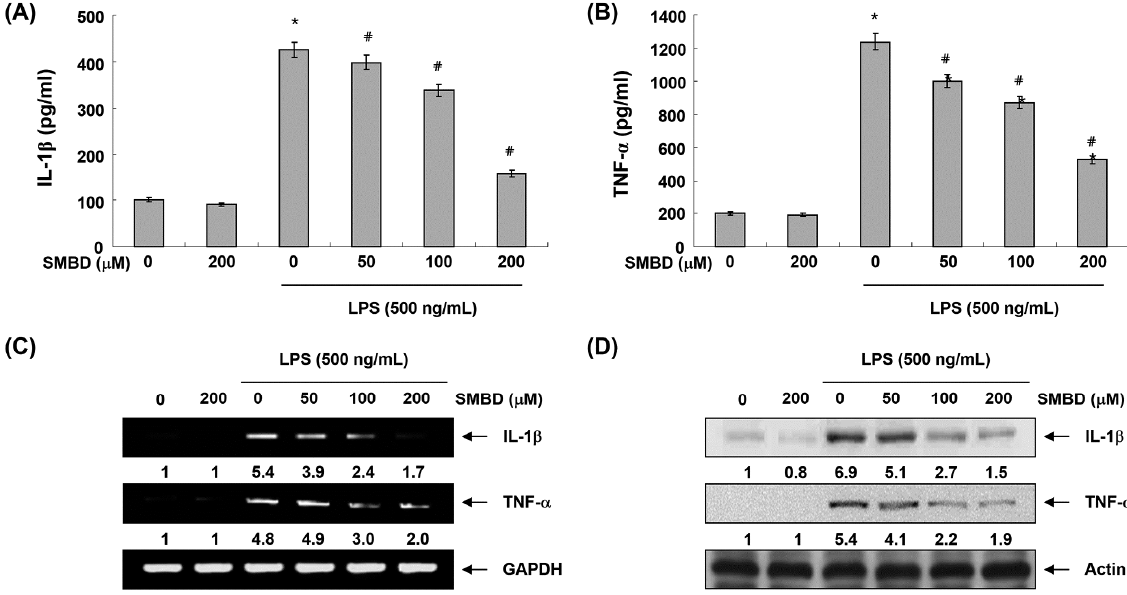
Figure 4. Effects SMBD on LPS-induced production and expression of IL-1 β and TNF- α in BV2 microglia. BV2 cells were pretreated with various concentrations of SMBD for 1 h and then stimulated by LPS for 24 h. ( A and B ) Productions of IL-1 β ( A ) and TNF- α ( B ) were measured using the corresponding ELISA kits. Data are presented as mean ± SEM, and are representative of triplicate experiments. * p < 0.05 compared to control (LPS-free); # p < 0.05 compared to cells cultured with 500 ng/mL LPS. The mRNA ( C ) and protein ( D ) levels of IL-1 β and TNF- α were determined by RT-PCR and Western blot analysis, respectively. The numbers represent the average densitometric analyses as compared with GAPDH (C) and actin (D) in, at a minimum, two or three different